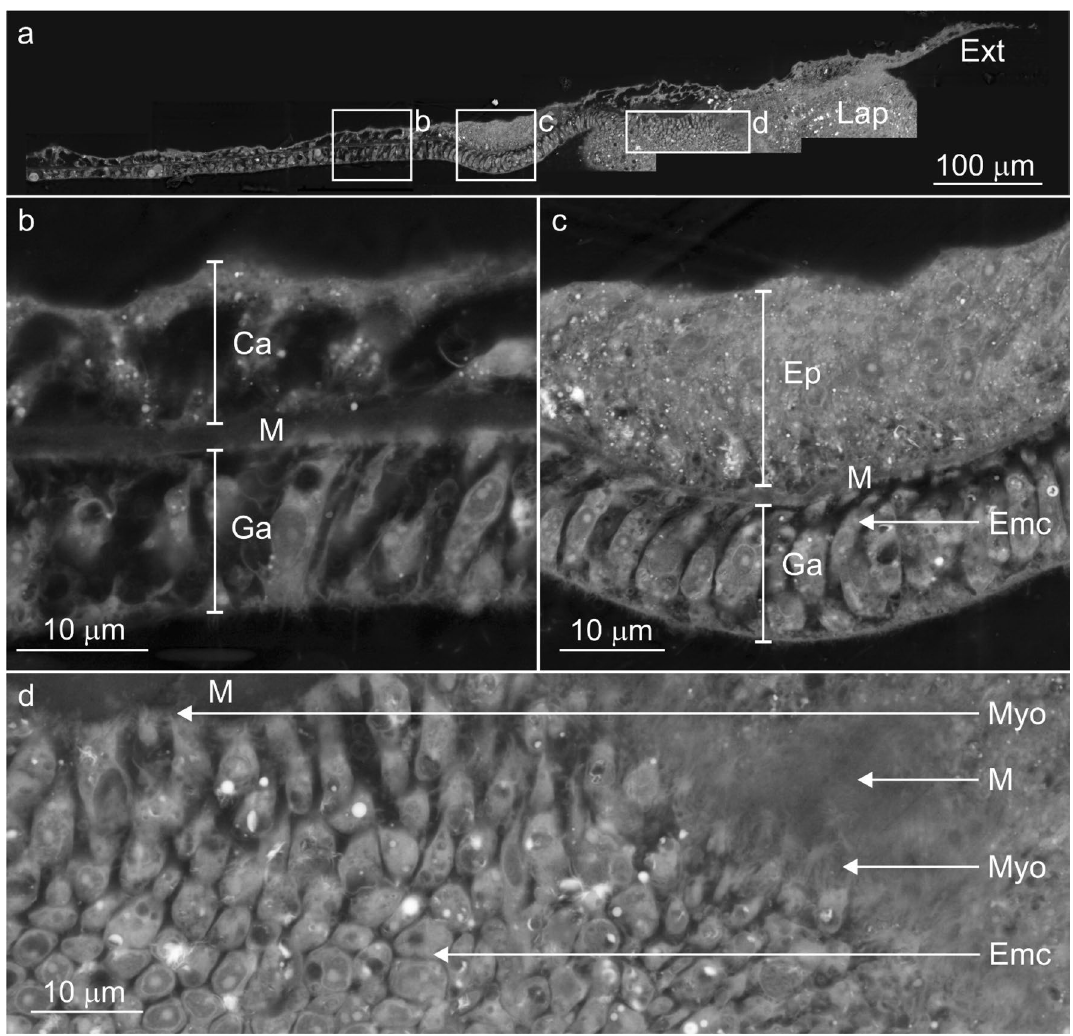
Figure 8. Backscatter electron microscopy images highlighting the primary cell composition of a newly developed lappet-like appendage. ( a ) The base of the developing lappet-like appendage (right) and the trailing basal body wall (BBW, left). ( b ) The standard BBW consists of two epithelial layers separated by the mesoglea (M); the calicodermis (Ca) primarily consists of cuboidal calicoblasts and a gastrodermis (Ga). ( c ) A pocket of vestigial epidermal cells that has not yet been removed by mesenterial filaments is still present in the BBW trailing the new lappet-like appendage. ( d ) The lappet-like primarily consists of epitheliomuscular cells (Emc) that attach to the mesoglea (M) by their filamentous myofibrils (Myo). The heightened musculature gives the lappet-like its complex undulated morphology and the mechanical ability to pulse and perhaps grip the surface. Lappet-like; Lap, costae; Cos, surface body wall; SBW, epidermis; Ep, transition zone; Trn, calicodermis extension; Ext, epitheliomuscular supporting cells;